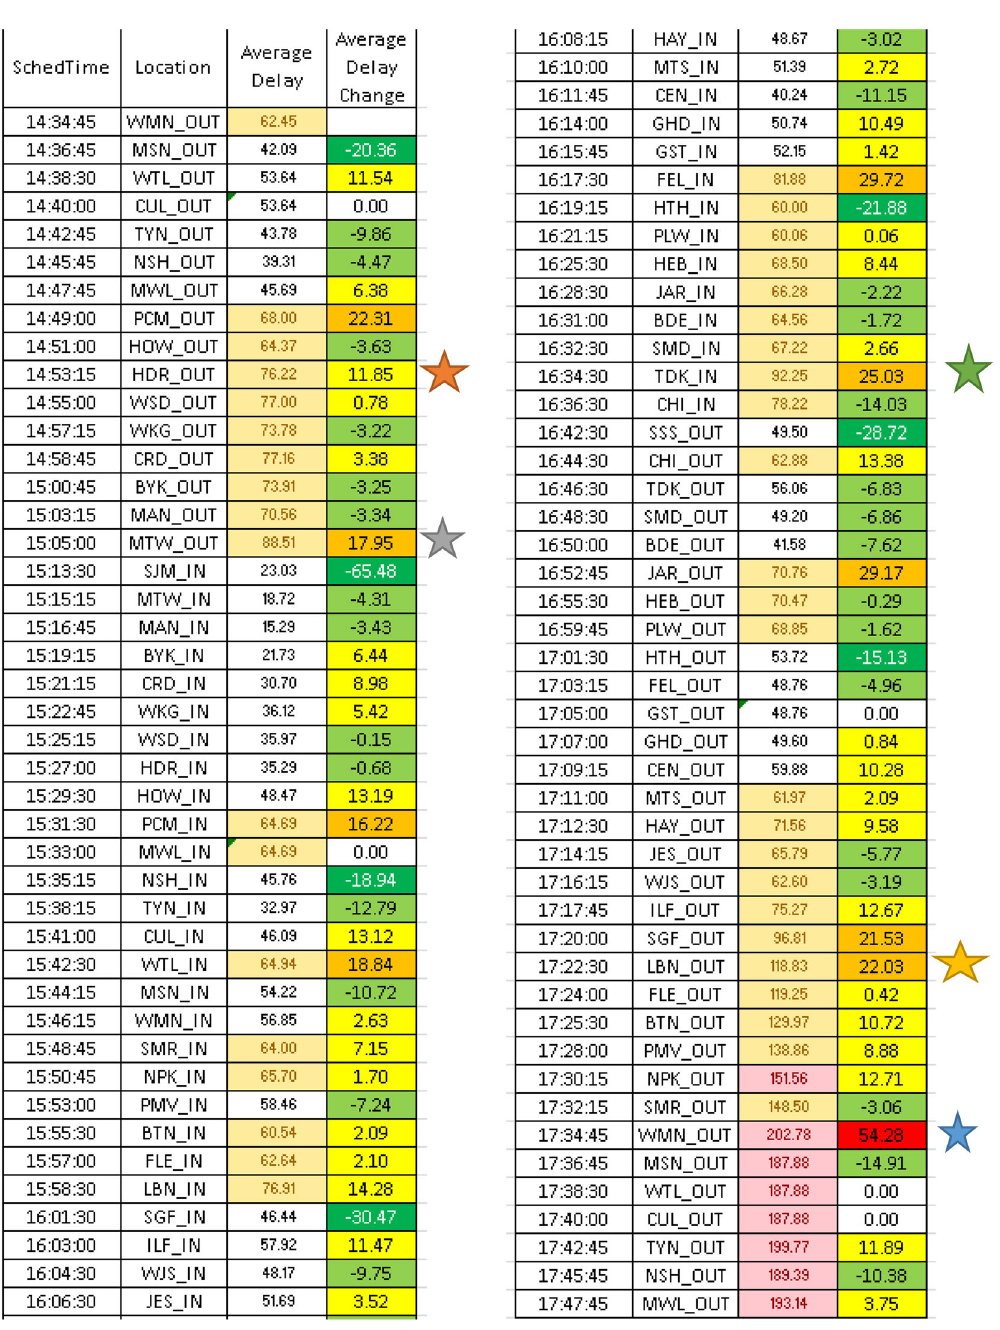
Fig. 4 Formatted table of average delays for the 125 metro train, with average delay of 60 s or more in yellow and 150 s or more in red, and average delay change of 0–15 s in yellow, 16–29 s in amber, and 30 s or more in red. Negative delay changes are shown in